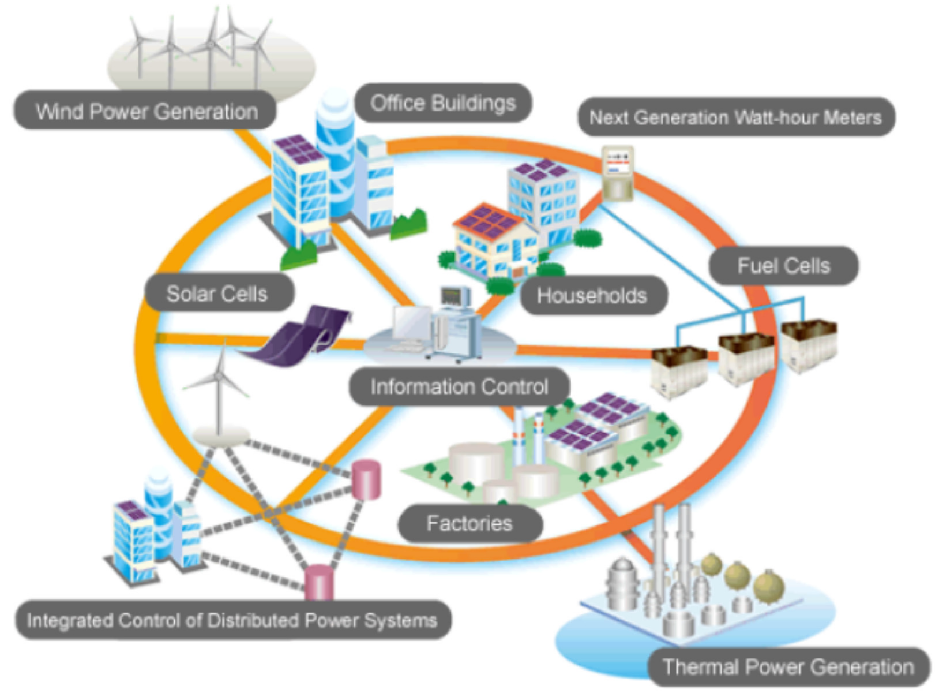
Figure 1. Main factors that influence the composition of a Smart